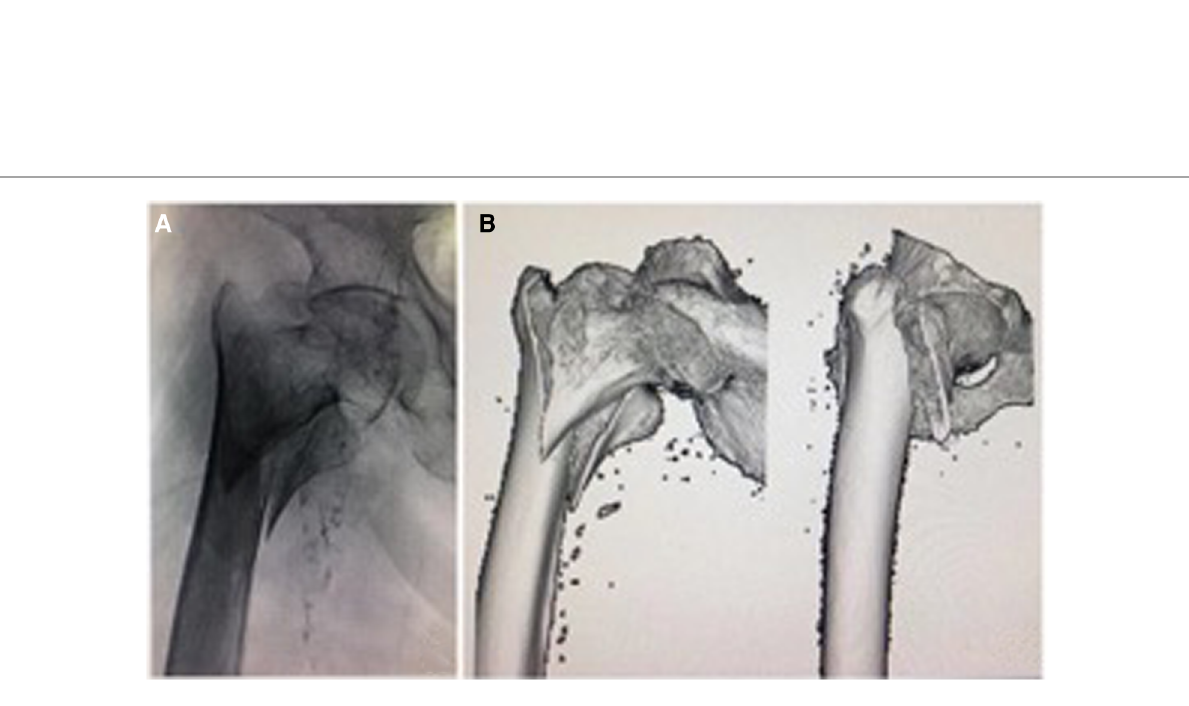
FIGURE 5 Intertrochanteric fracture in another patient, a 97-year-old woman, in which the medial arch was involved and displaced anteriorly. Preoperative x-ray ( A ) and CT scan ( B ) show that the intertrochanteric fracture and the medial arch fragment were displaced